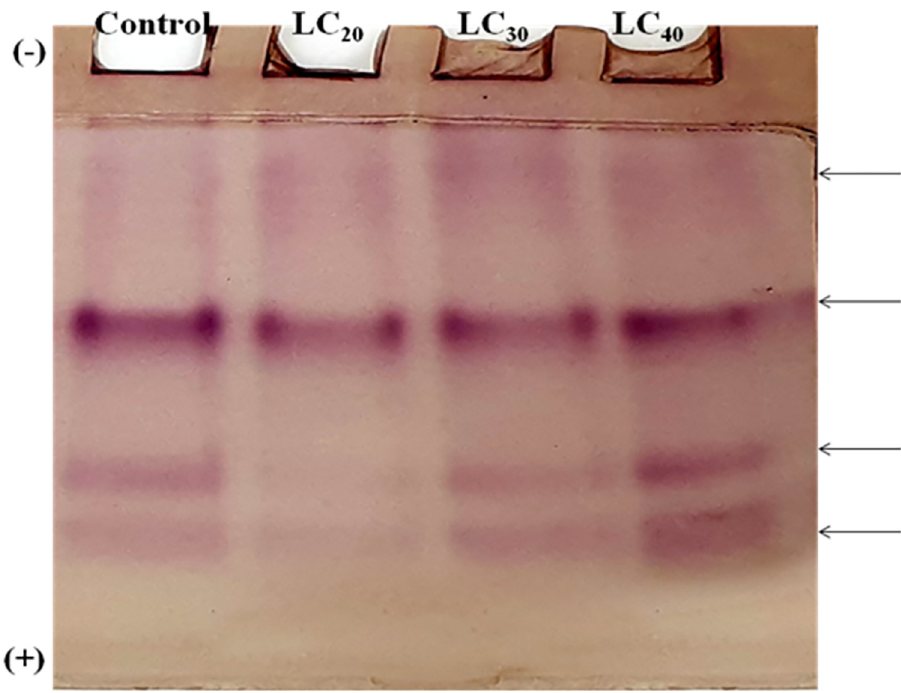
Fig 2. Qualitative analysis of isoenzyme of β -Carboxylesterases of T . castaneum adult after treatment with essential oil of C . Citrinus